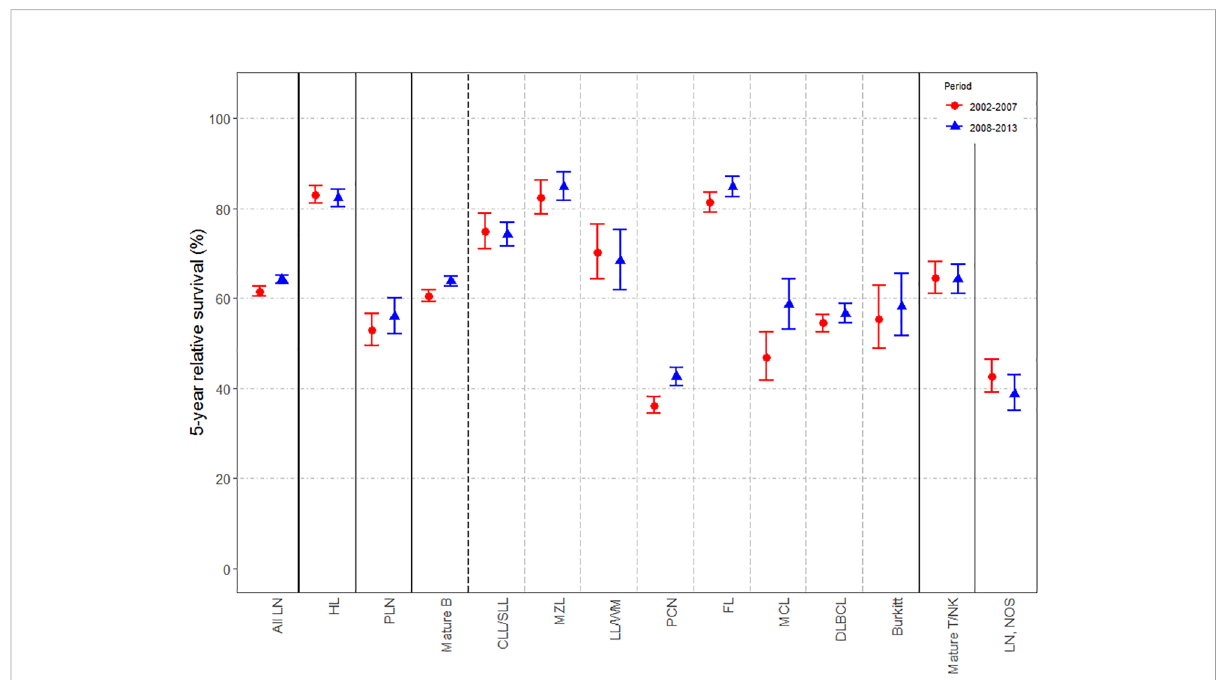
FIGURE 3 Estimates of 5-year net survival for patients with lymphoid neoplasms diagnosed in 2002-2013, in Spain, according to period of diagnosis (2002- 2007 and 2008-2013). LN, Lymphoid neoplasm; HL, Hodgkin lymphoma; PLN, precursor lymphoid neoplasms; mature B, mature B-cell neoplasms; CLL/SLL, chronic lymphocytic leukemia/small lymphocytic lymphoma; MZL, marginal zone lymphoma; LL/WM, lymphoplasmacytic lymphoma/ Waldenström ’ s macroglobulinemia; PCN, plasma cell neoplasms; FL, follicular lymphoma; MCL, mantle cell lymphoma; DLBCL, diffuse large B-cell lymphoma; Burkitt, Burkitt lymphoma/leukemia; Mature T/NK, mature T-cell and NK-celll neoplasms; NOS, not otherwise speci fi